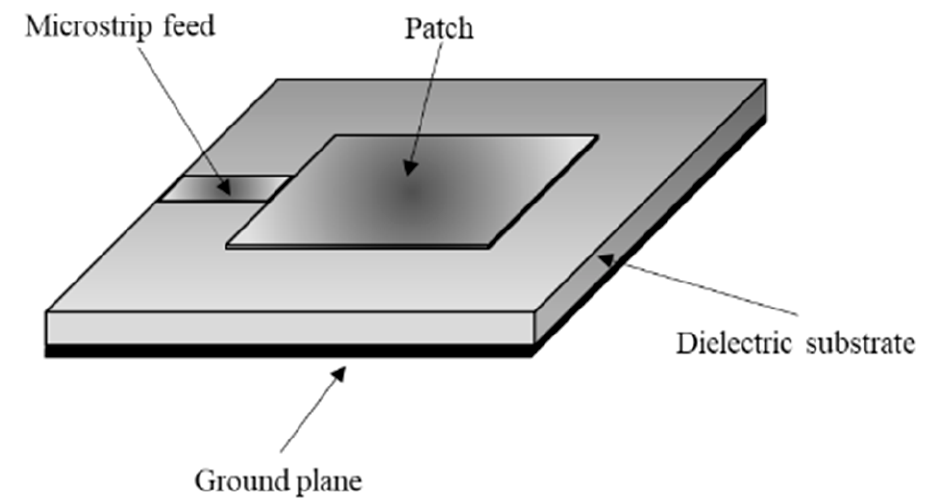
Figure 3. Schematic illustration of a planar microstrip patch antenna.